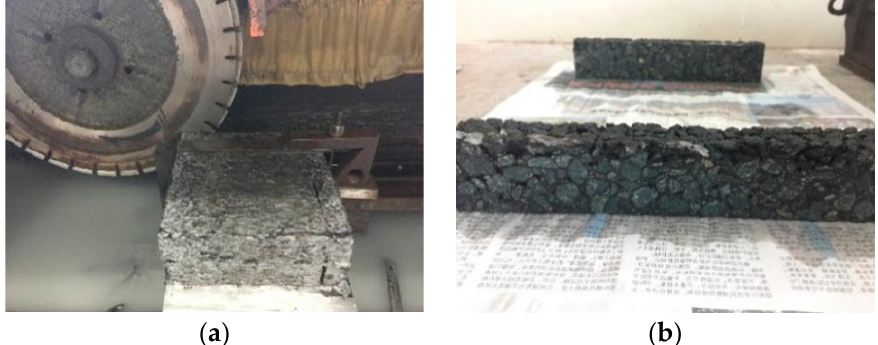
Figure 7. ( a ) Fabrication of prismatic specimen; ( b ) prismatic specimen prior to testing.